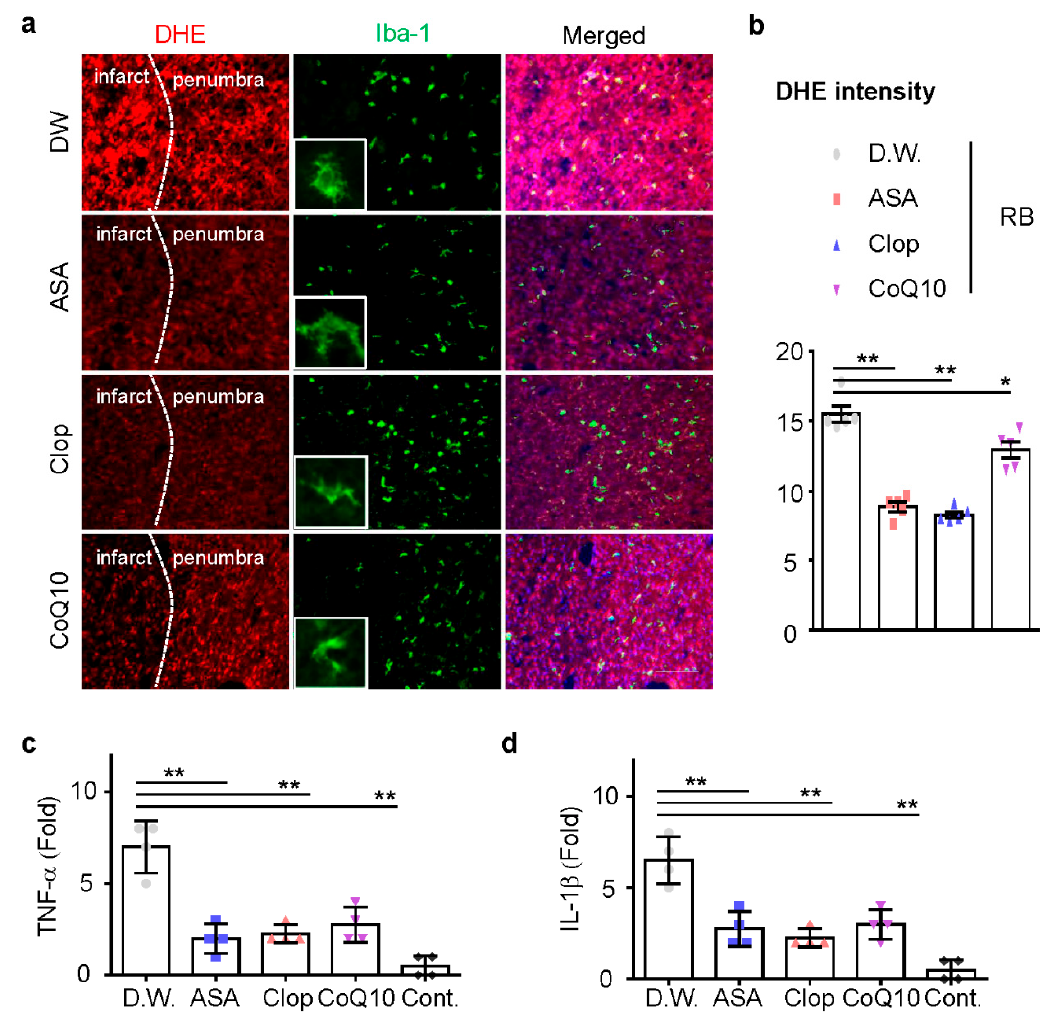
Figure 4. Reactive oxygen species (ROS) production and microglia activation in the penumbra. ( a ) Representative images of ROS-dependent Dihydroethidium (DHE) fluorescence in the penumbra part of the infarct brain. ( n = 5, total n = 20) ( b ) DHE staining density measured using the Image J software. The total mRNA was isolated from the cortex of the ipsilateral brain at day 1 after RB modeling and utilized for cDNA synthesis. The expression of TNF- α ( c ) and IL-1 β ( d ) mRNA was measured by qRT-PCR ( n = 4, total n = 16). Data are presented as the mean ± SD. ** p < 0.005; * p < 0.01 compared with the D.W. group. Scale bar = 50 µm.